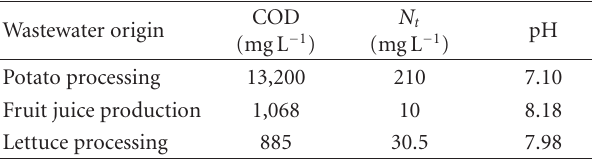
Table 1: Initial chemical oxygen demand (COD), total nitrogen content ( N t ), and pH value measured in the collected